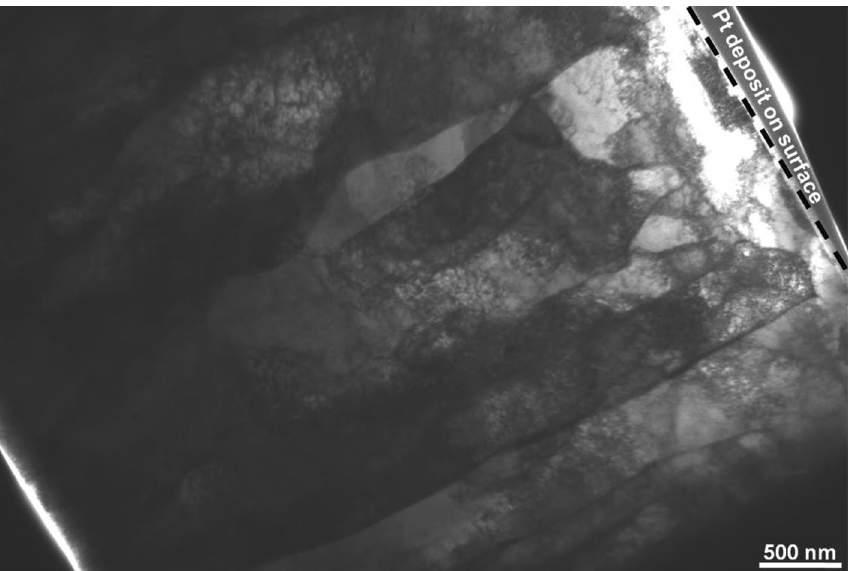
Figure 12. Bright-field TEM micrograph of the FIB lamella depicting the crosssection of sampleirradiated to 0.2 dpa at 77 K temperature.